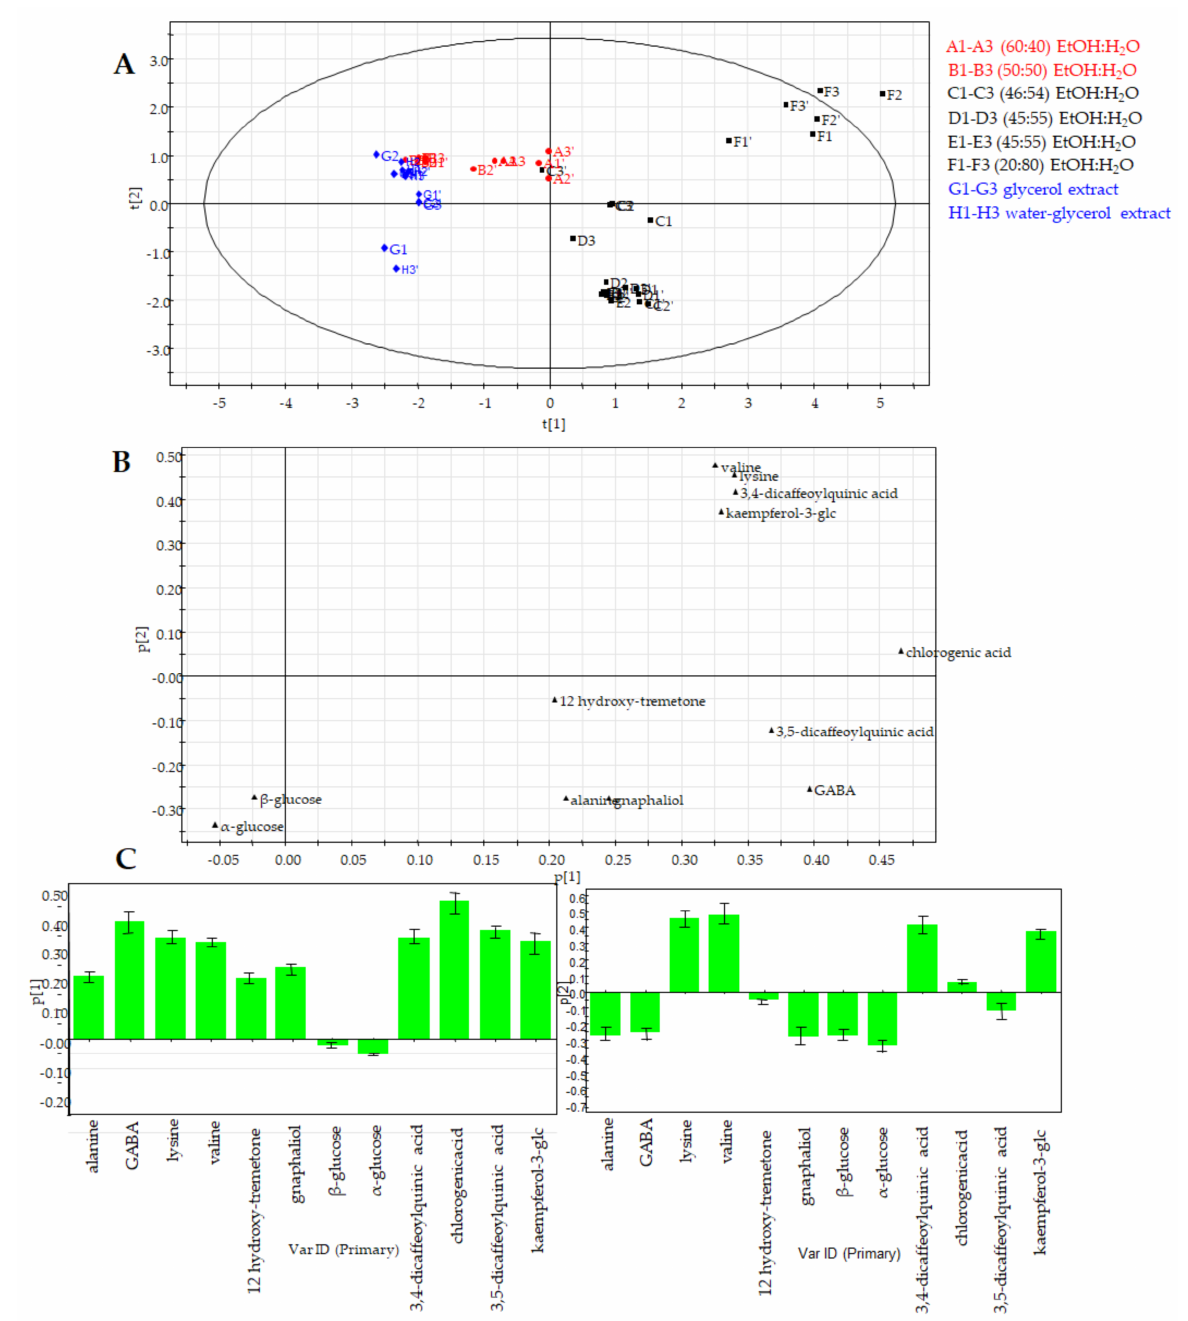
Figure 6. PLS-DA of H. italicum derived food supplements ( A : 60:40; B : 50:50; C : 46:54; D and E : 45:55; F : 20:80 EtOH-H 2 O extracts; G : glycerol extract; H : water-glycerol extract) obtained by targeted analysis. ( A ) PLS-DA score scatter plot; ( B ) PLS-DA loading plot; ( C ) PLS-DA loading column